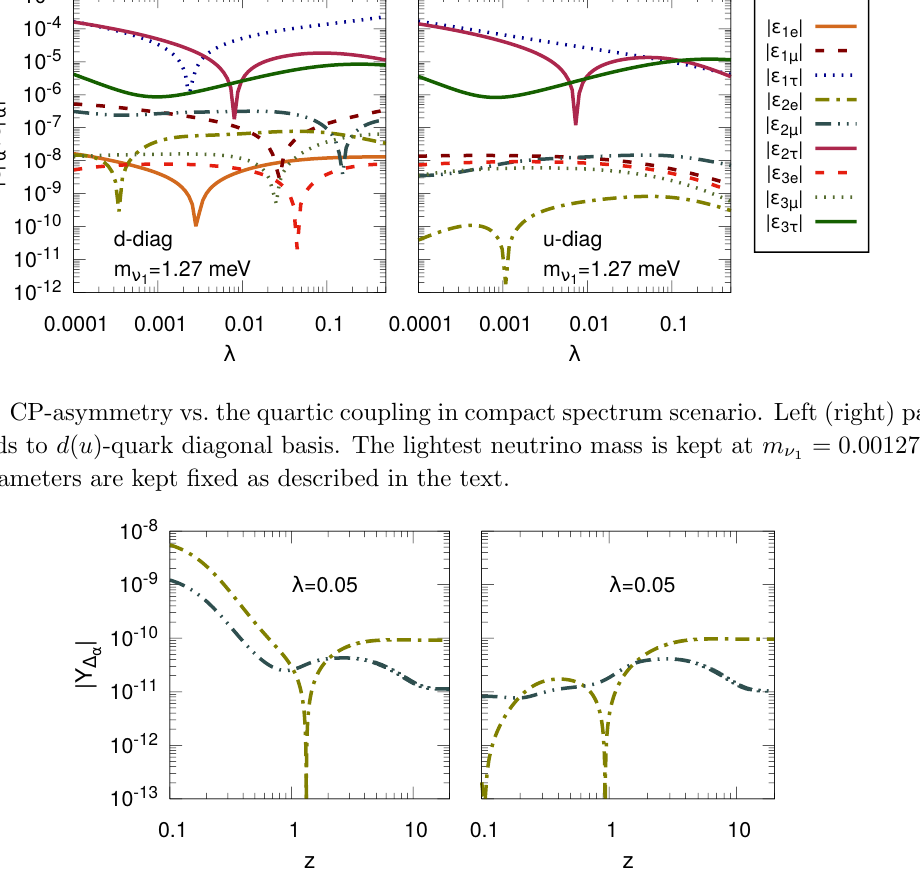
Figure 8 . The baryon asymmetry in e + (cid:22) (cid:13)avours (double-dot-dashed blue curve) and (cid:28) (cid:13)avor (dot- dashed curve) for the u -quark diagonal basis and compact spectrum RH (cid:23) mass scenario. Left (right) panel correspond to non-zero (zero) initial thermal abundance. The quartic coupling (cid:21) = 0 :